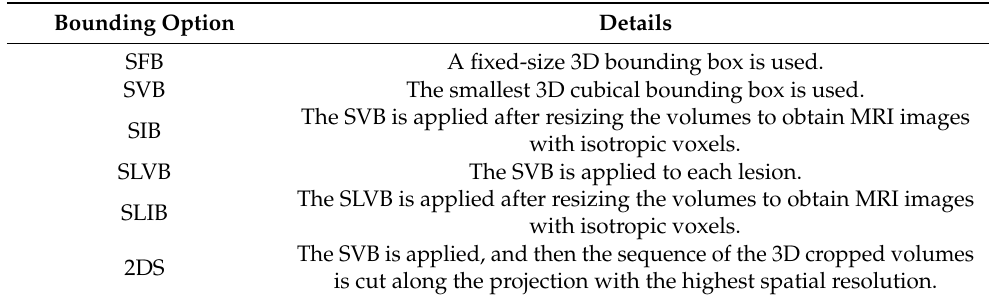
Table 2. Details of the proposed bounding box